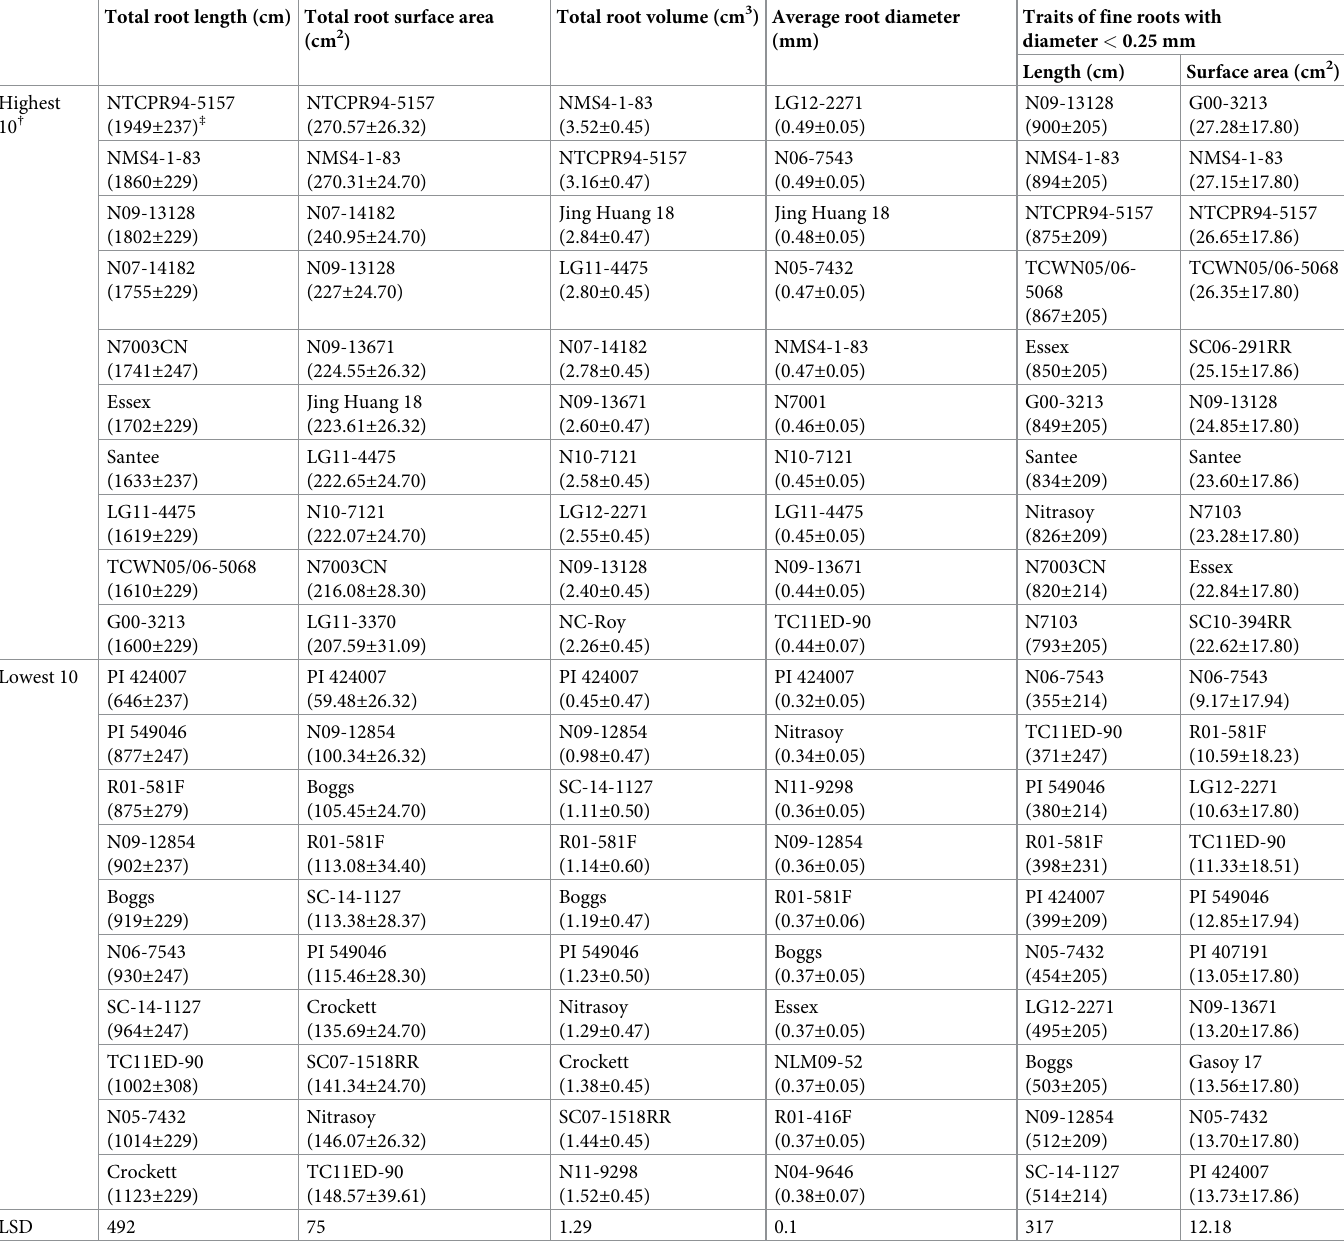
Table 4. Soybean genotypes that were ranked high and low for total root length, total root surface area, total root volume, average root diameter, and fine root (diameter < 0.25 mm) length and surface area. Total root length (cm) Total root surface area (cm 2